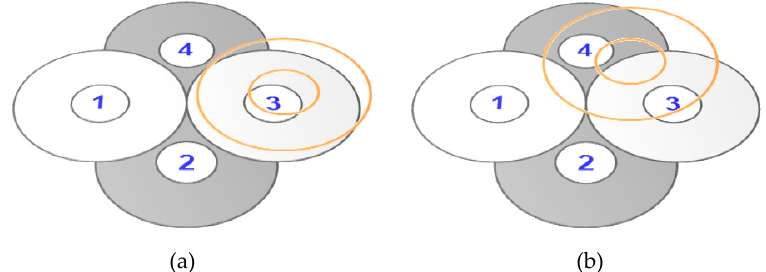
Figure 11. Position of the receiver coil: ( a ) Close to the center of transmitter coil number 3; ( b ) Between transmitter coil numbers 3 and 4.